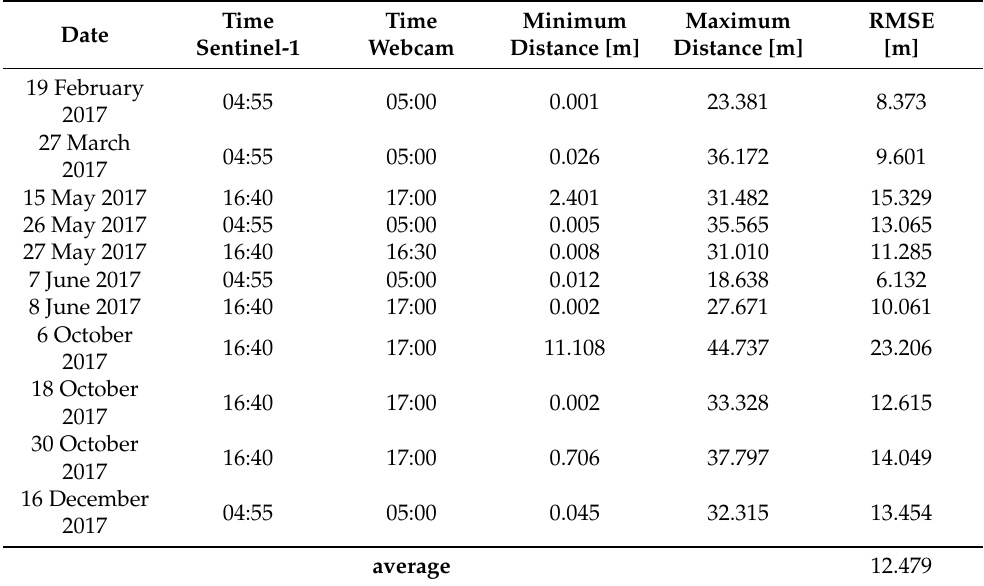
Figure 6. Example of the shoreline extracted along Torre Canne beaches and overlapped on the corresponding Sentinel-1 image. Shoreline extracted by VMS is shown with a blue line whereas SDS is represents by a red line. Table 1. Results of the validation measures estimated for each